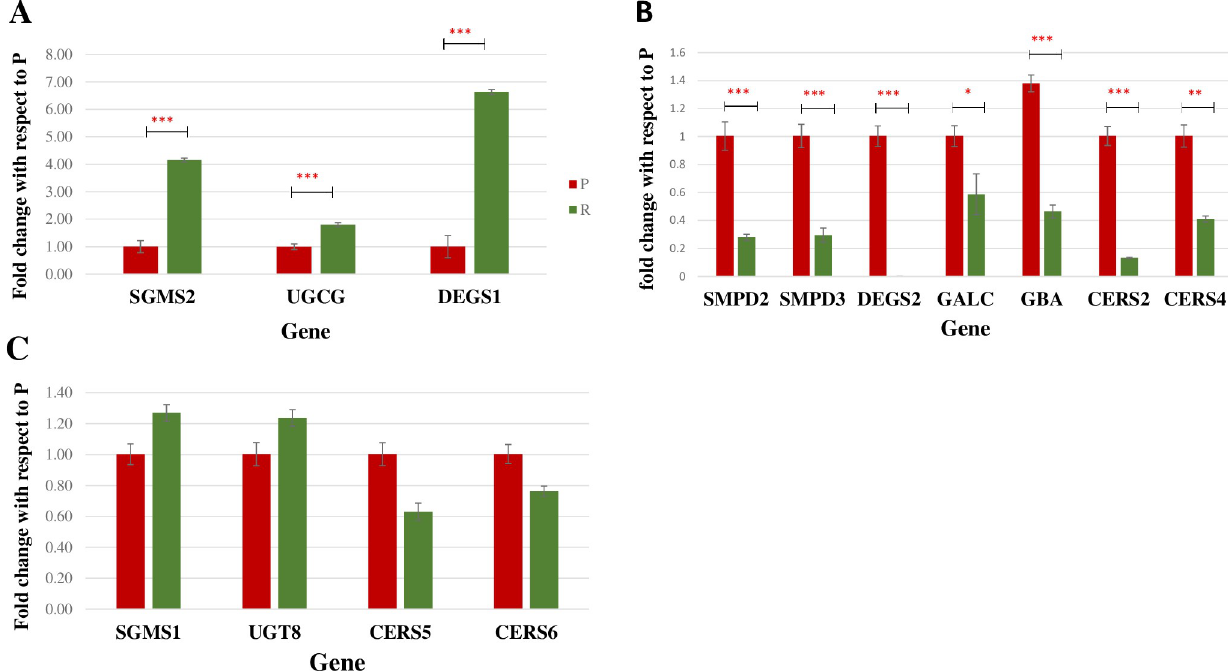
Fig 4. Relative mRNA expression levels of 14 genes in (P) Parental and (R) dox-resistant MCF-7 cells. ( A ) Transcripts showed a significant increase in the gene expression level in dox-resistant MCF-7. ( B ) Transcripts showed a significant increase in gene expression level in parental MCF-7. ( C ) Transcripts that showed no significant difference in gene expression between parental and dox-resistant MCF-7. ��� Indicates P -value < 0.001, �� indicates P - value < 0.01, and � indicates P -value < 0.05. UGCG; UDP-glucose ceramide glucosyltransferase, CERS 2; Ceramide synthase 2, CERS 4; Ceramide synthase 4, SGMS1; Sphingomyelin synthase 1, SGMS2; Sphingomyelin synthase 2, SMPD2; Sphingomyelin phosphodiesterase \neutral sphingomyelinase 2, SMPD3; Sphingomyelin phosphodiesterase neutral sphingomyelinase 3, DEGS1; Dihydroceramide desaturase 1, DEGS2; Dihydroceramide desaturase 2, CERS5; Ceramide synthase 5, GBA; Glucosylceramidase beta, GALC; beta-galactosylceramidase, CERS6; Ceramide synthase 6, UGT8/CGT; ceramide galactosyltransferase.